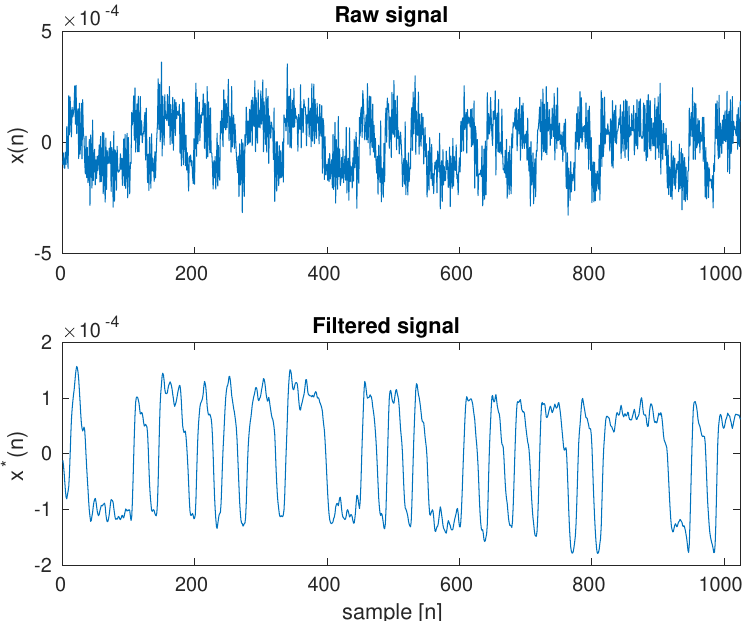
Figure 19. Waveforms for the selective brightness of video sequence frames. Raw and filtered wave- forms a random transmitted sequence with 2-PAM modulation are shown. Brightness modulation with LCD backlight. Scenario with strong brightness